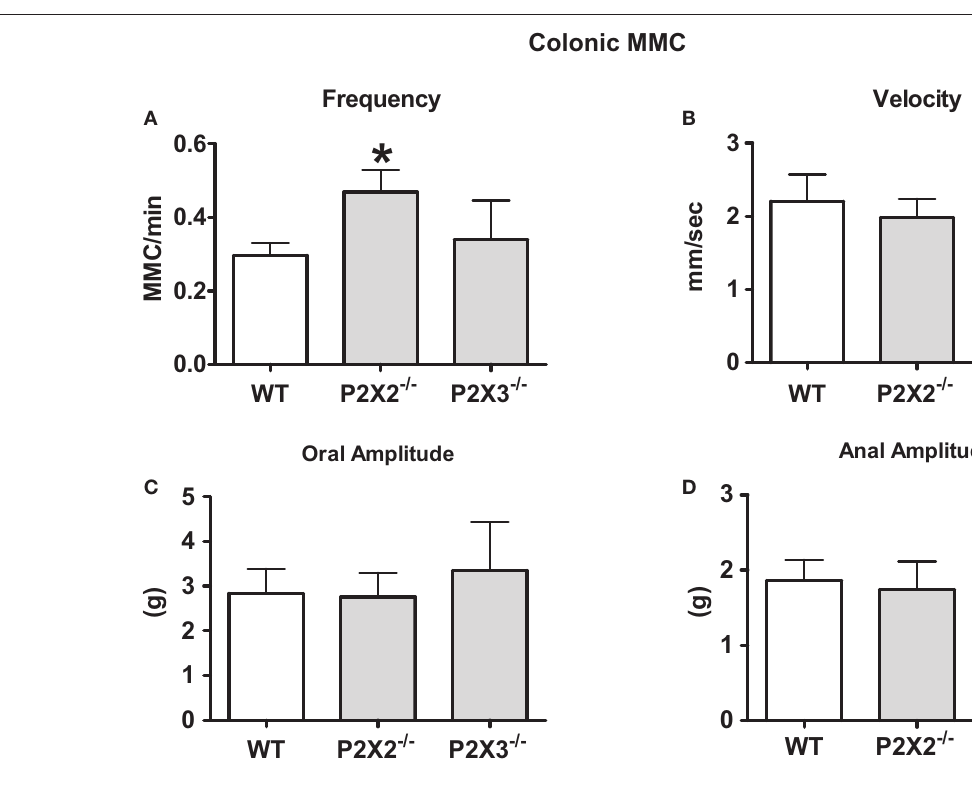
Figure 4 | Properties of MMCs were similar in colon segments from WT and P2X2 and P2X3 KO mice. (A) The frequency of colonic MMC was increased in colonic segments from P2X2 but not P2X3 subunit KO mice when compared to WT colonic segments ( P < 0.05). (B) The velocity of colonic MMC propagation